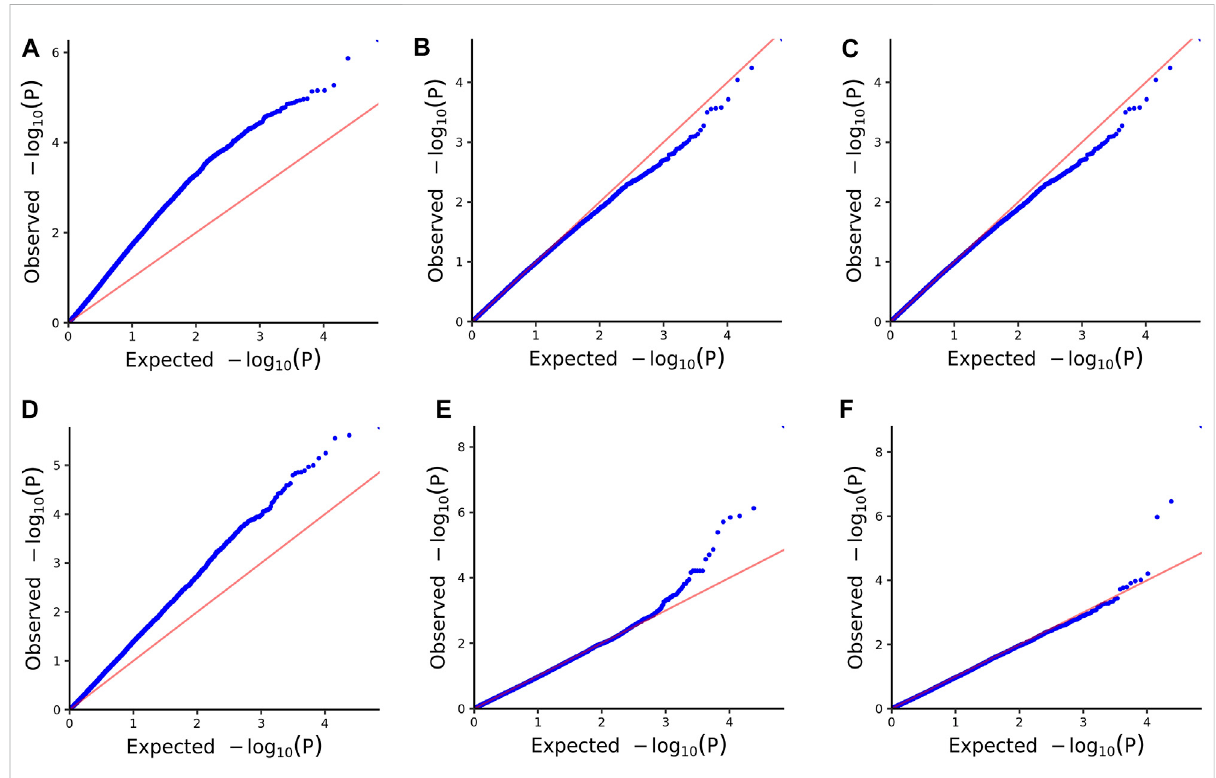
FIGURE 2 Quantile-quantile (QQ) plots of the six models. (A) GLM. (B) MLM. (C) CMLM. (D) SUPER. (E) FarmCPU. (F) Blink.